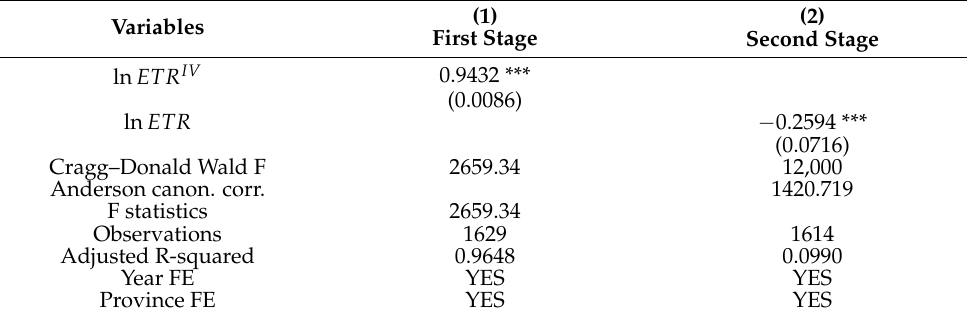
Table 3. IV regression